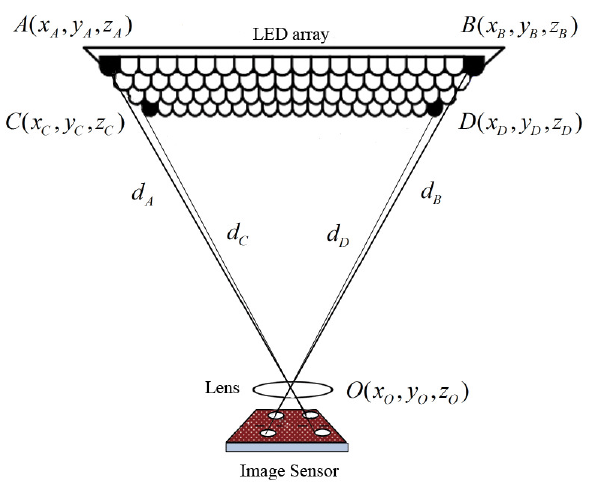
Figure 1. Proposed VLC-based positioning